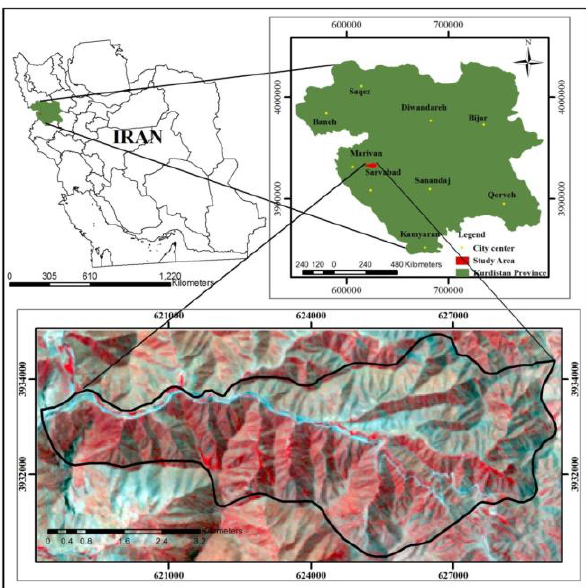
Figure 1. Location of the study area in Iran (a), Kurdistan province (b), and the color-composite (Band 4, 3, 2) of Landsat 5 TM imagery (c) of the study area